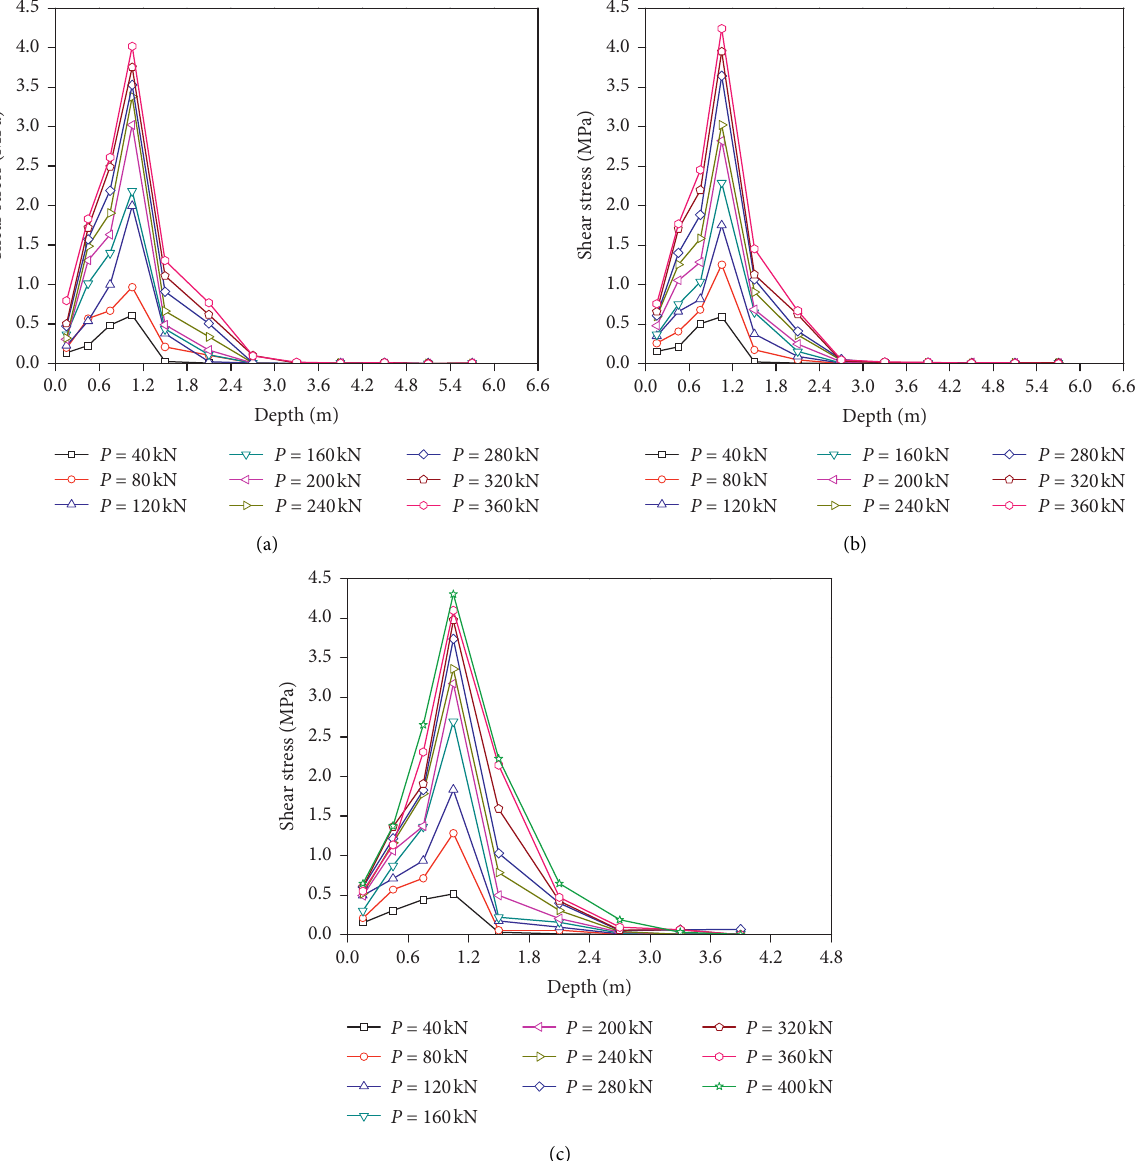
Figure 14: Shear stress of the first interface at different depths: (a) G-28-6.5-1, (b) G-28-6.5-2, and (c)